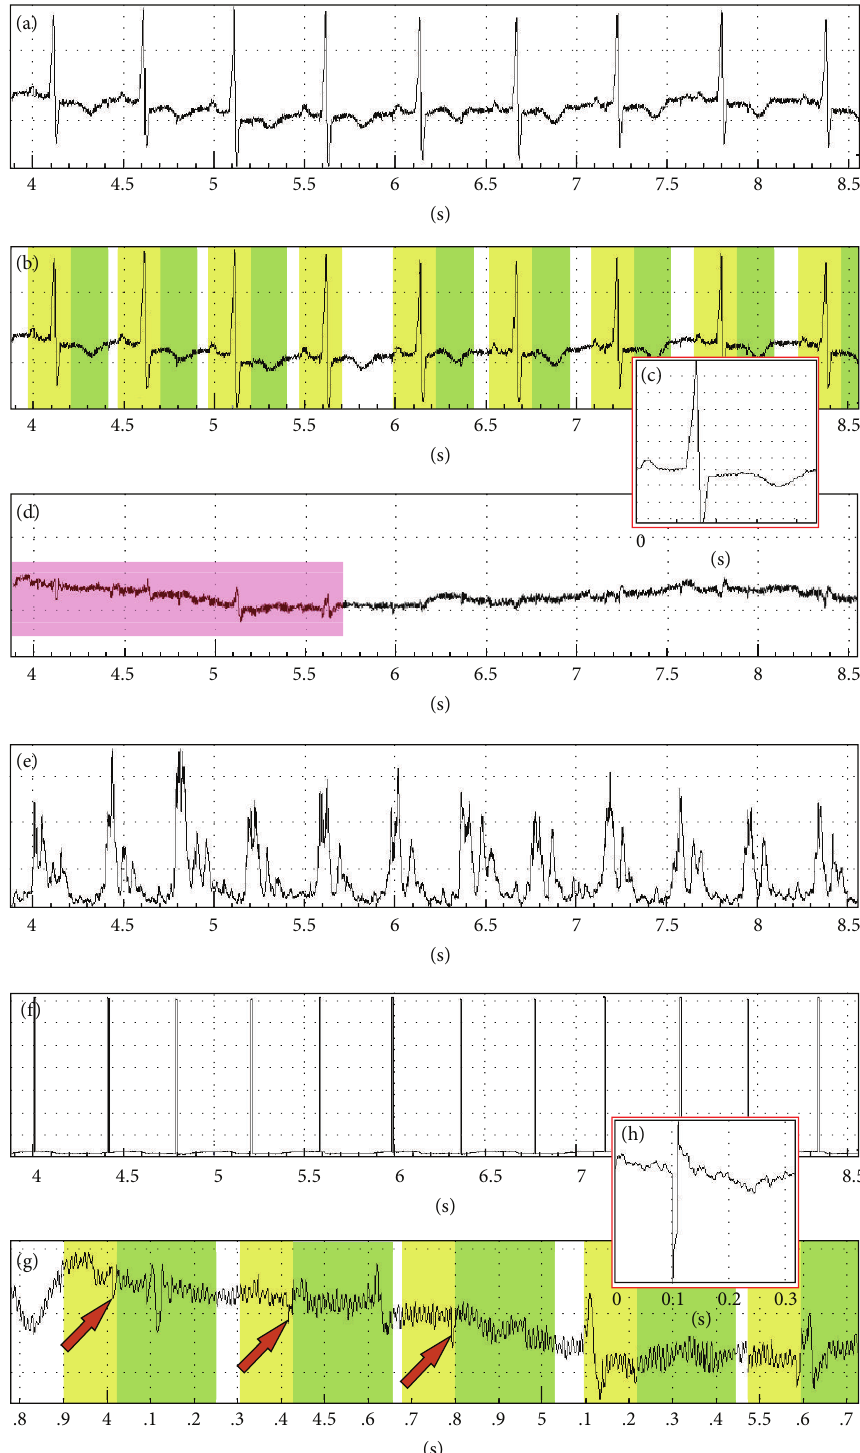
Figure 3: (a) Transabdominal record at the 34th week of pregnancy. Contrary to previous recordings, fetal signals are so small in this case that they cannot be identified. (b) The software automatically identifies the maternal ECG R waves. (c) The system calculates the average of 30 maternal cardiac cycles, and then the computer extracts in real time the averaged signal from each identified maternal ECG heart event. (d) The “cleaned” abdominal signal, maternal waves are removed. (e) The preprocessed sound signals of the cardiotocograph can be used to identify fetal cardiac events. (f) The hardware generates automatically trigger signs from the acoustic waves. (g) The identified fetal signals are averaged (in this case 76 fetal heart events are averaged). (h) The final result is an approximately true-to-form fetal ECG. It is important to emphasize that in the example shown above the fetal ECGs amplitude is less than 10 𝜇